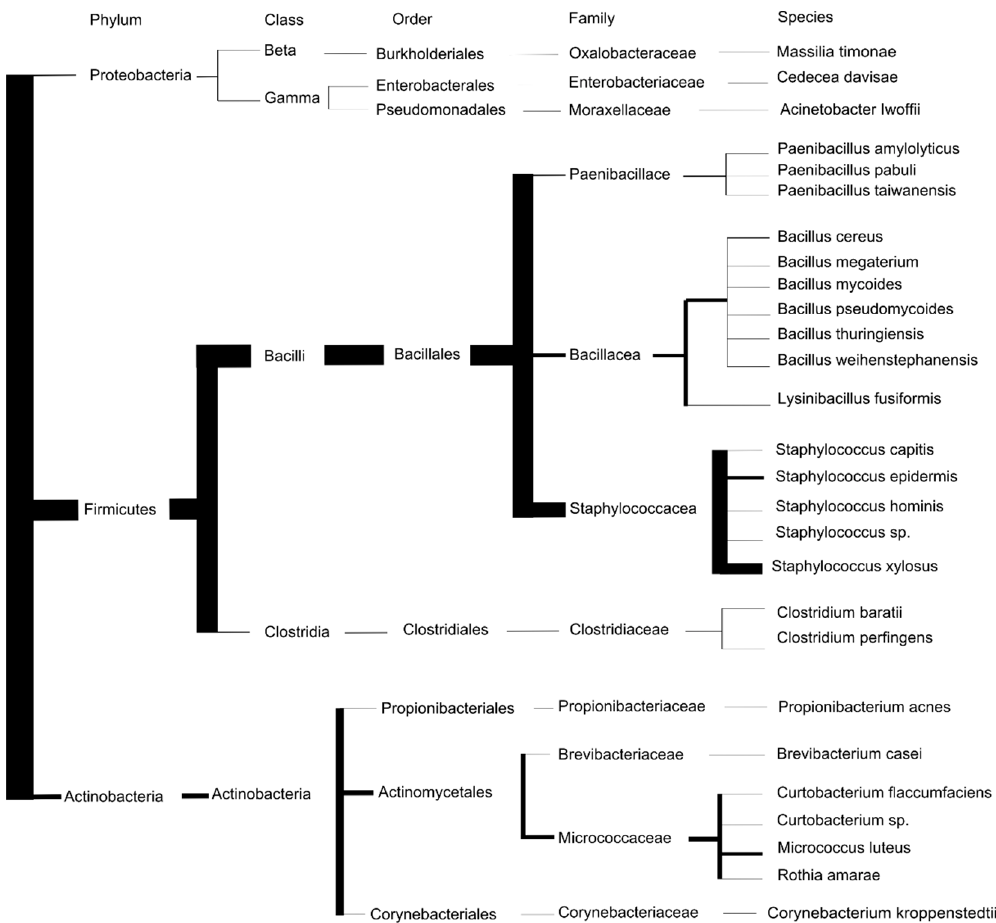
Figure 3. Dendrogram of bacterial species adapted from Bryksin and Matsumura [31] with permission. Branch lengths do not represent evolutionary distance. Branch widths represent the number of bacteria isolated. Only species related to this study are shown.